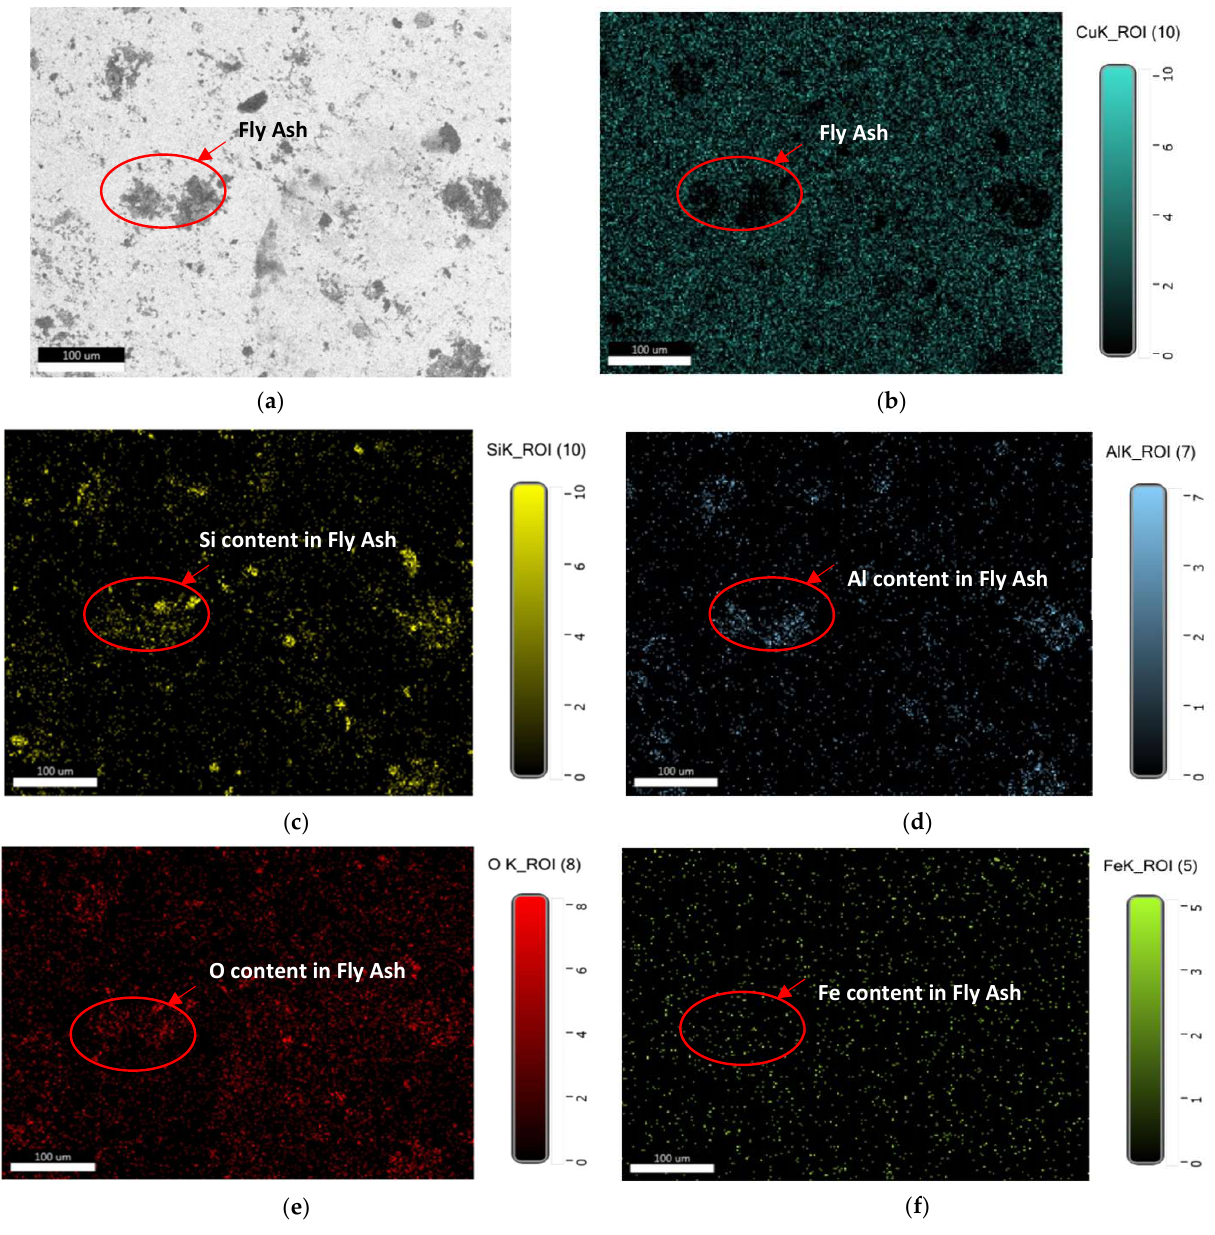
Figure 4. Elements in the composite’s EDX mapping: ( a ) SEM image; ( b ) copper mapping; ( c ) silica mapping; ( d ) alumina mapping; ( e ) oxygen mapping; ( f ) iron mapping.